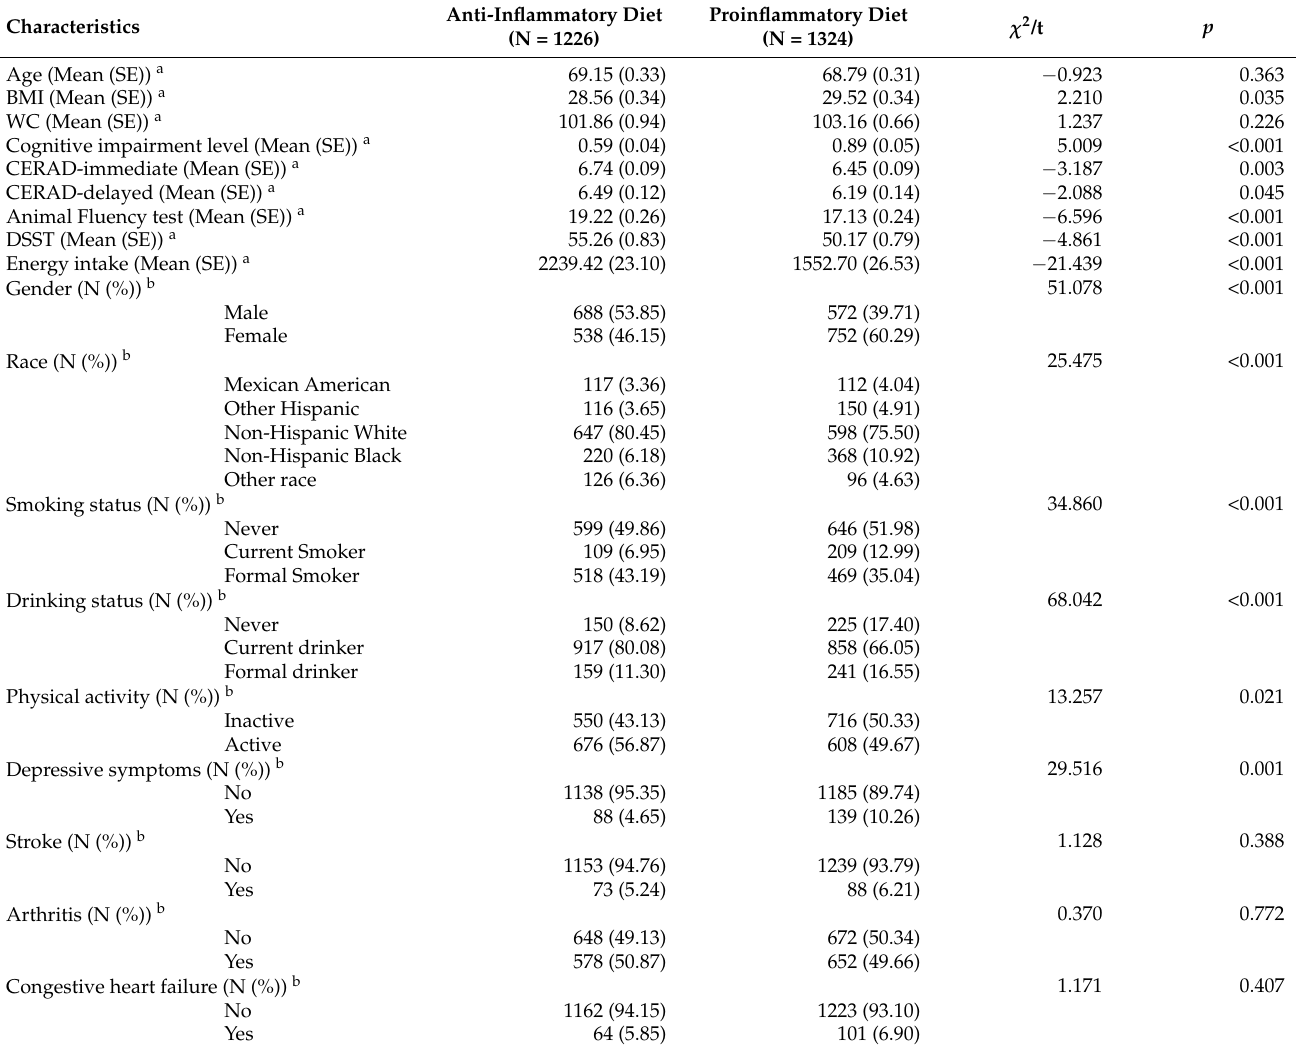
Table 1. Characteristics of the participants with an anti-inflammatory diet and proinflammatory diet (Mean